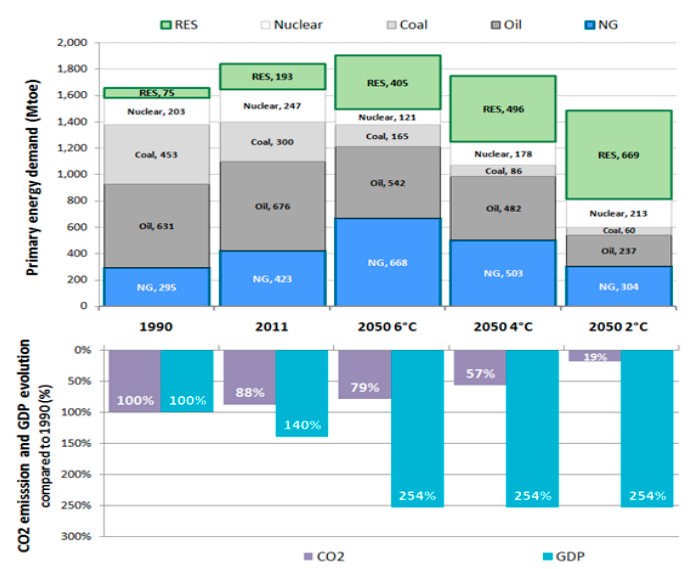
Figure 1. EU energy related indicators (1990 2011 and ETP2014 scenarios to